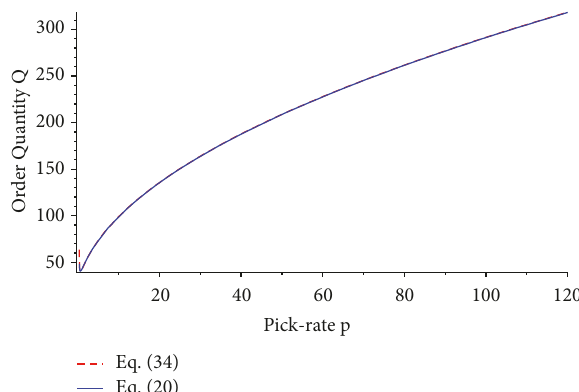
Figure 6: Approximate and exact optimal transfer batch quantity 𝑄 ∗